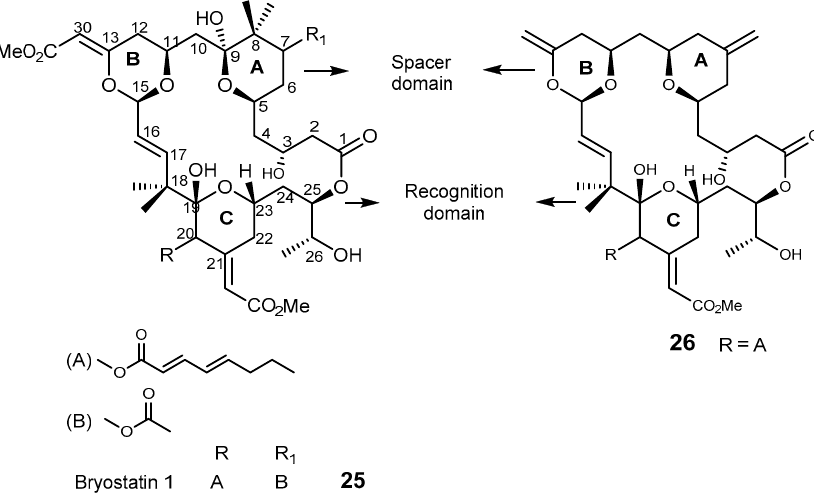
Figure 5. The structures of bryostatin 1 ( 25 ) and merle 23 ( 26 ).